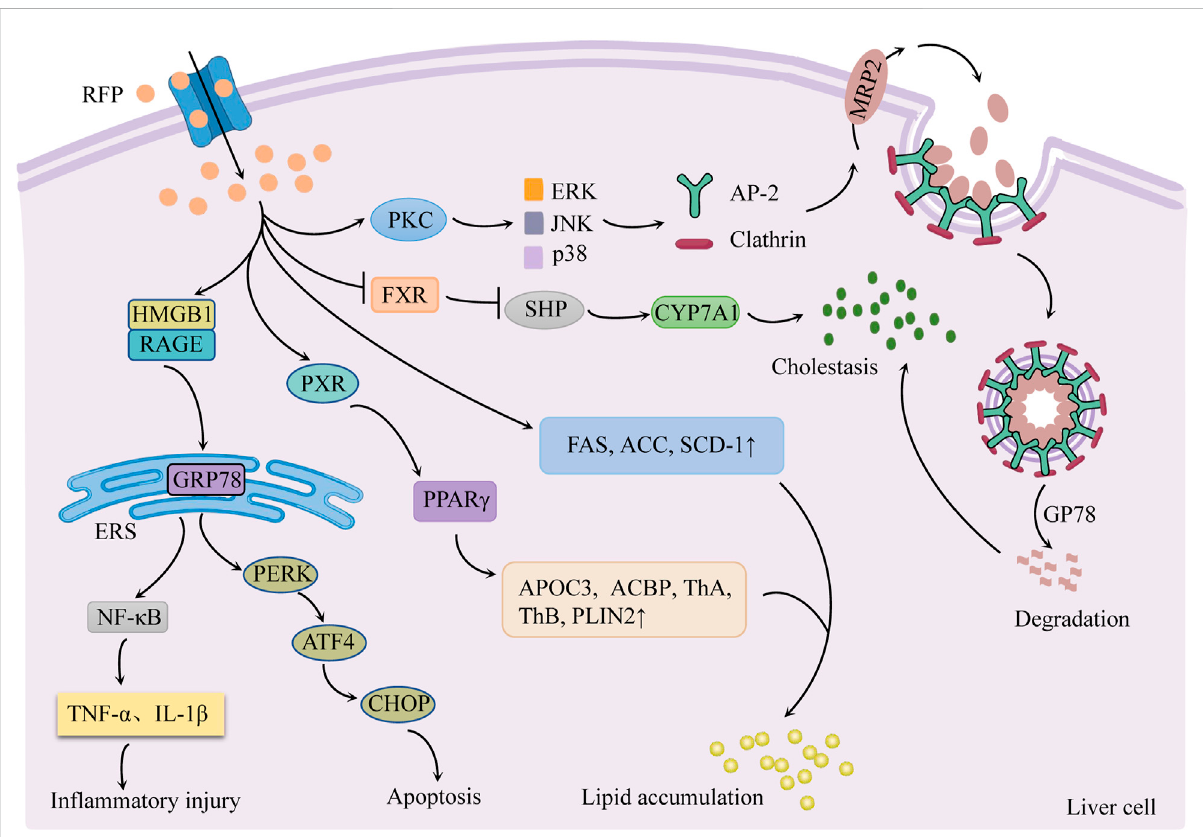
FIGURE 3 Schematic diagram of the molecular mechanisms of RFP-induced liver injury. Inhibition of FXR/SHP pathway promotes bile synthesis and activatesPKC/ERK/JNK/p38 pathwaytoinhibitbiletransportleadingtocholestasis.Regulation ofPERK/ATF4/CHOPandHMGB1/RAGEpathwaysto generate endoplasmic reticulum stress. RFP promotes hepatic fatty acid synthesis and absorption, respectively, by regulating hepatic fatty acid- related factors, resulting in the accumulation of hepatic lipids. Notes: RFP, rifampicin; FXR: farnesoid X receptor; SHP: small heterodimer partner; CYP7A1, cholesterol 7 α hydroxylase; PKC, protein kinase C; ERK, extracellular signal-regulated kinases; JNK, c-jun N-terminal kinase; p38, p38 mitogen-activated protein kinases; AP-2, adaptin 2; GP78: E3 ubiquitin ligase; MRP2: multidrug resistance-associated protein 2; GRP78, glucose-regulatedprotein78;HMGB1,highmobilitygroupbox1protein;RAGE:receptorforadvancedglycationendproducts;PERK,proteinkinase R-like endoplasmic reticulum kinase;ATF4, activating transcriptionfactor4;CHOP,C/EBPhomologousprotein;ERS,endoplasmicreticulum stress; NF- κ B,nuclearfactor- κ B;FAS,fattyacidsynthase;ACC,acetylCoAcarboxylase;SCD-1:stearoylCoAdesaturase1;PXR:pregnaneXreceptor;PPAR- γ , peroxisome proliferator-activated receptor- γ ; APOC3, apolipoprotein C-III, ACBP: acyl-CoA-binding protein; ThA, 3-ketoacyl-CoA thiolase